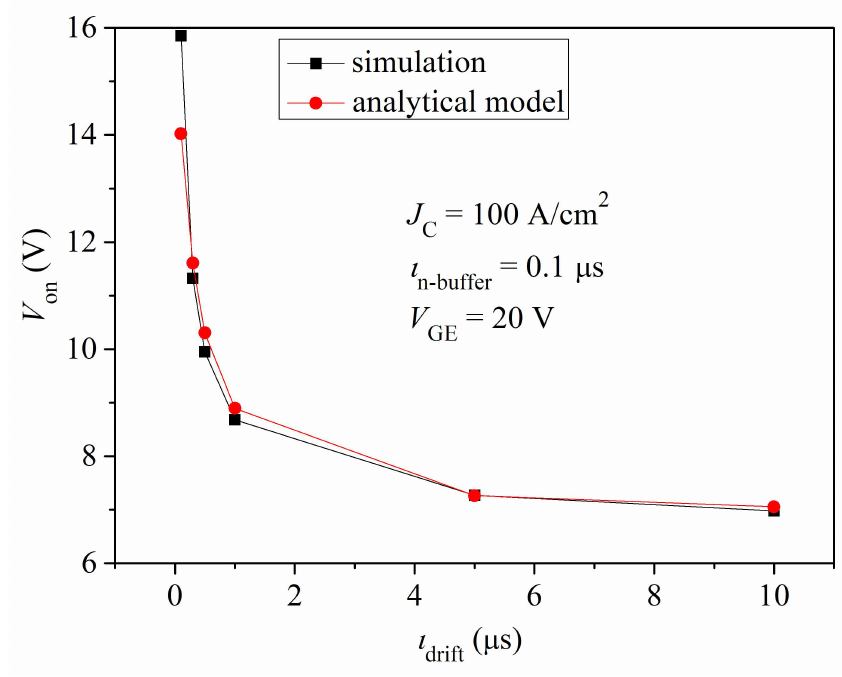
Figure 4. Influence of carrier lifetime in the drift region on forward voltage